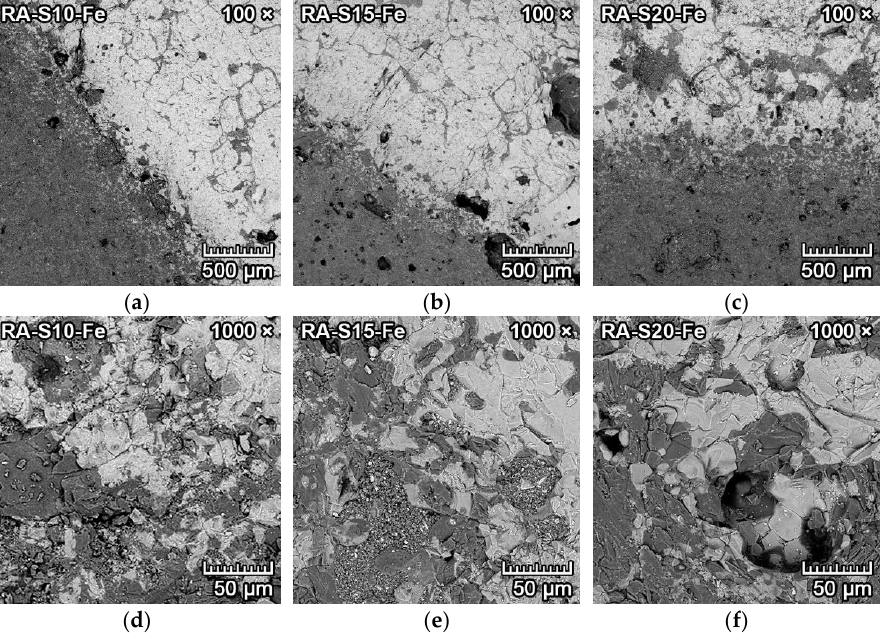
Figure 7. SEM microstructure of the transition zone between iron (light grey) and forsterite – spinel ceramics (dark grey) of reactive alumina – based mixtures RA-S10, RA-S15 and RA-S20, with a mag- ceramics (dark grey) of reactive alumina–based mixtures RA-S10, RA-S15 and RA-S20, with a magni- nification of 100× ( a – c ) and a magnification of 1000× ( d – f ). fication of 100 × ( a – c ) and a magnification of 1000 × ( d – f